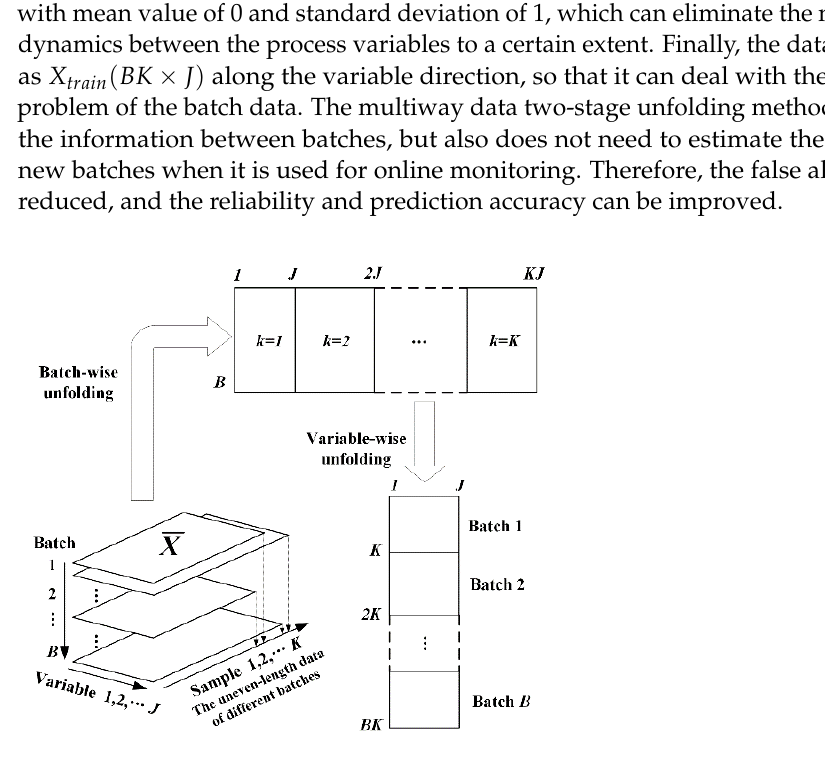
Figure 2. Diagram of the two-stage batch data unfolding for the plasticizing process.